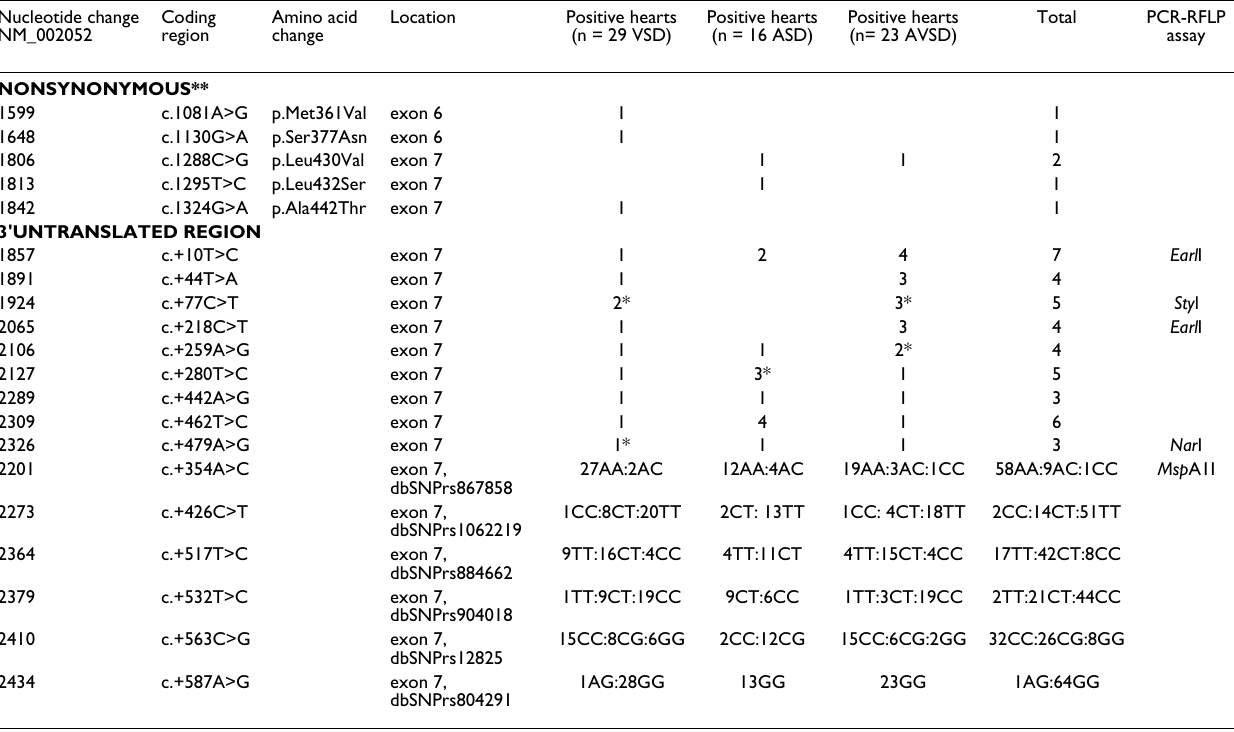
Table 2: Summary of GATA4 sequence variations in diseased cardiac tissues of patients with CHD Nucleotide change Coding NM_002052 region